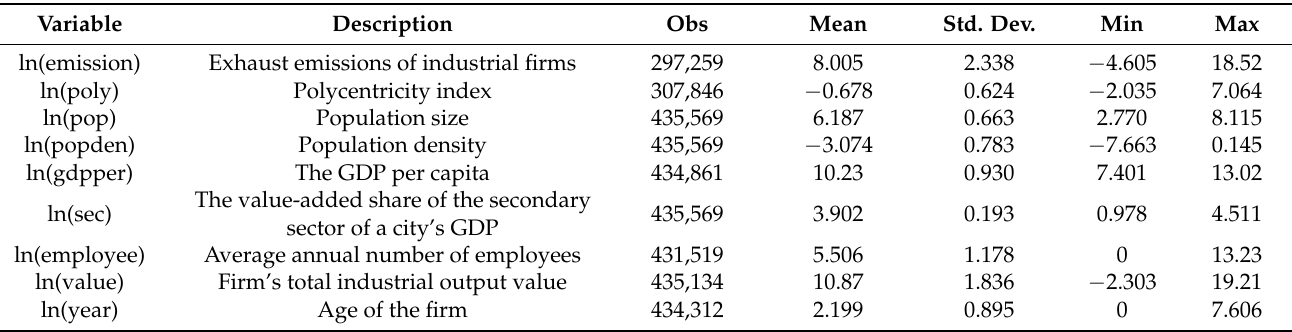
Table 1. Descriptive statistics of variables.